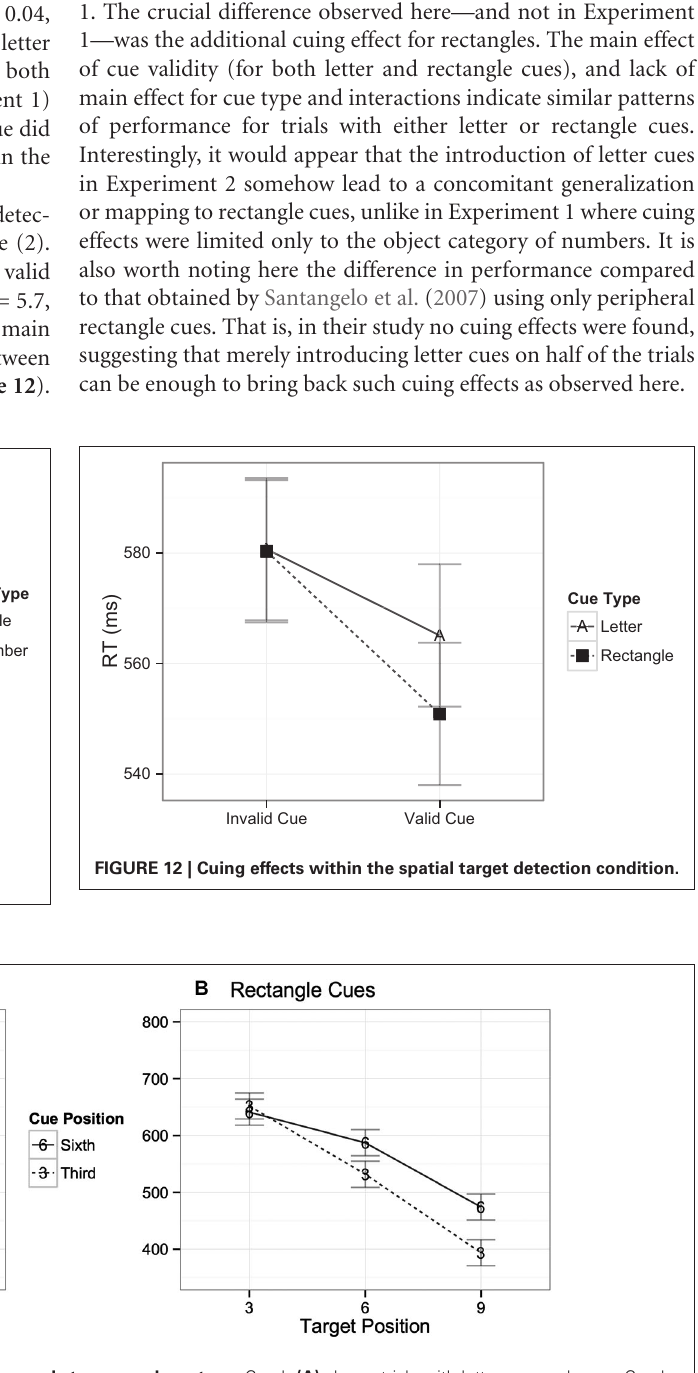
Frontiers in Integrative